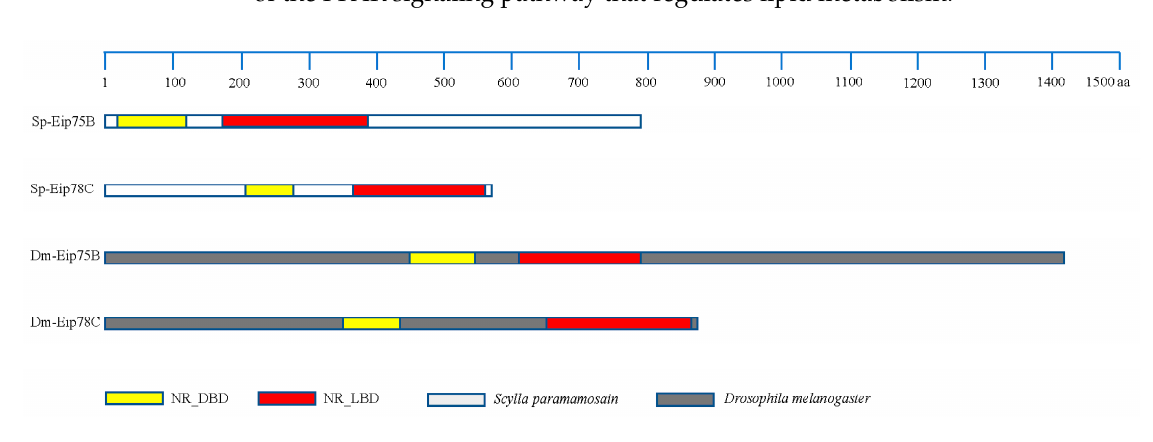
Figure 7. Domain architectures of the PPAR γ -homologs, Eip75B and Eip 78C, in Drosophila melanogaster and S. paramamosain . Sp-Eip75B/78C : ecdysone-induced protein E75B/78C in S. paramamosain ; Dm-Eip75B/78C: ecdysone-induced protein E75B/E78C in Drosophila melanogaster . NR_LBD: Ligand-binding domain (LBD) of nuclear receptor (NR); NR_DBD: DNA binding domain (DBD) of nuclear receptor (NR).